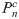
Virality as a function of threshold.Shows virality (V) as a function of the average threshold value (θ), for different levels of opinion polarization (Po). The upper, filled line for each Po shows virality at the critical level of network polarization (i.e the Pn for which the effects of the presence of a cluster, V(θc, Pn, Po) − V(θc, Pn, 0) = ΔV(θc, Pn, Po), peaks for some given Po, denoted Pnc) and the lower, dashed line for an Erdős-Rényi network. The upper figure shows the case (the nodes in the echo chamber are opinion polarized), while the lower shows the control (opinion polarization is assigned to random nodes in the network.) Two things should be noted: (i) The relationship between threshold and virality is far from linear, and (ii) as can be seen, the distance between the dashed and filled lines becomes significantly wider in the case than in the control: this tentatively suggests the presence of a synergic interaction between network and opinion polarization.